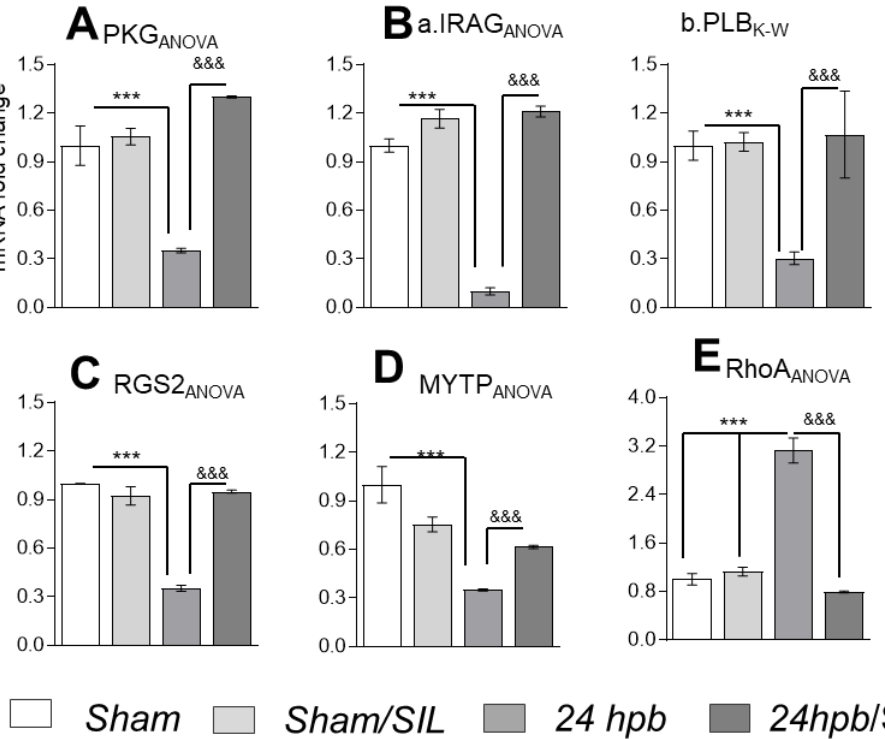
Figure 5. The e ff ect of PDE5A inhibition on downstream gene expression after a burn. Sprague–Dawley rats were randomized to a 60% TBSA scald burn or sham procedure with standard resuscitation with / without sildenafil (SIL). Heart tissues and blood were harvested at 24 h post burn (24 hpb ± SIL). Isolated heart tissue RNAs (RNeasy Mini Kit) were used to synthesize cDNAs (The SuperScript III First-Strand Synthesis System), and mRNA level was measured by qRT-PCR. ( A ) Myocardial levels of PKG mRNA. ( B ) Myocardial levels of cGMP-PKG pathway markers, including IRAG (a) and PLB (b) mRNA levels. ( C ) Myocardial level of RGS2 mRNA. ( D ) Myocardial level of RhoA mRNA. ( E ) Myocardial levels of MYTP mRNA levels. Results were normalized to rat GAPDH